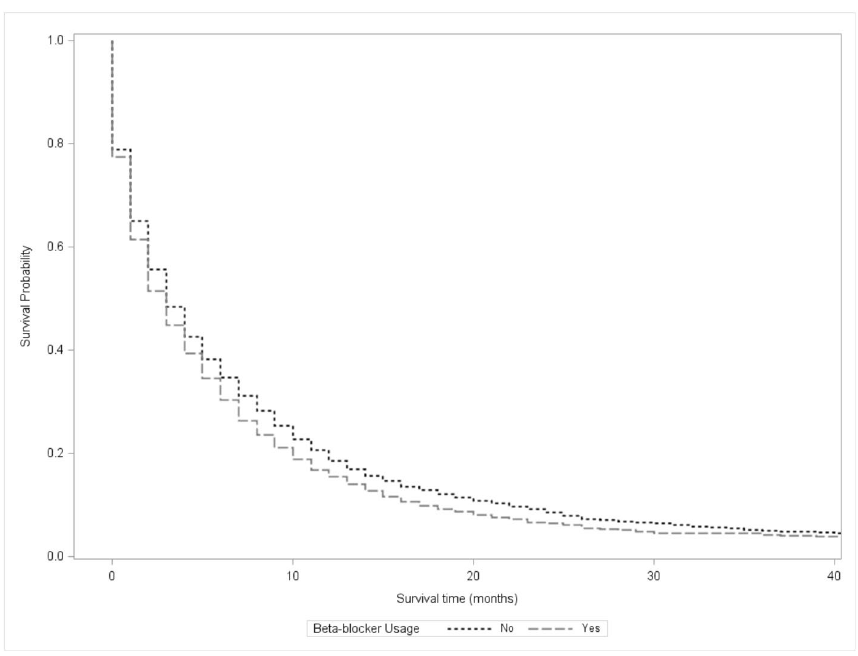
Figure 2. Kaplan–Meier Curve comparing survival of patient using beta-blockers 6 months before diagnosis to patients not using beta-blockers, p < 0.001.